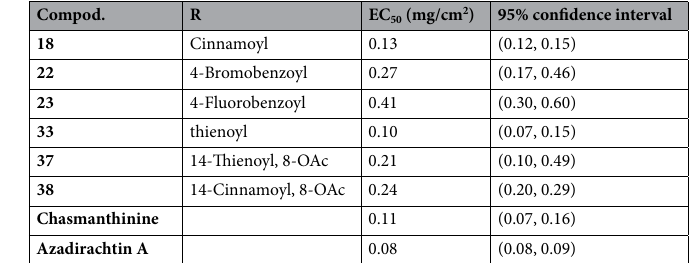
Table 2. EC 50 values of antifeedant activity of title compounds against S. exigua (Hübner). The experiments were repeated three times.